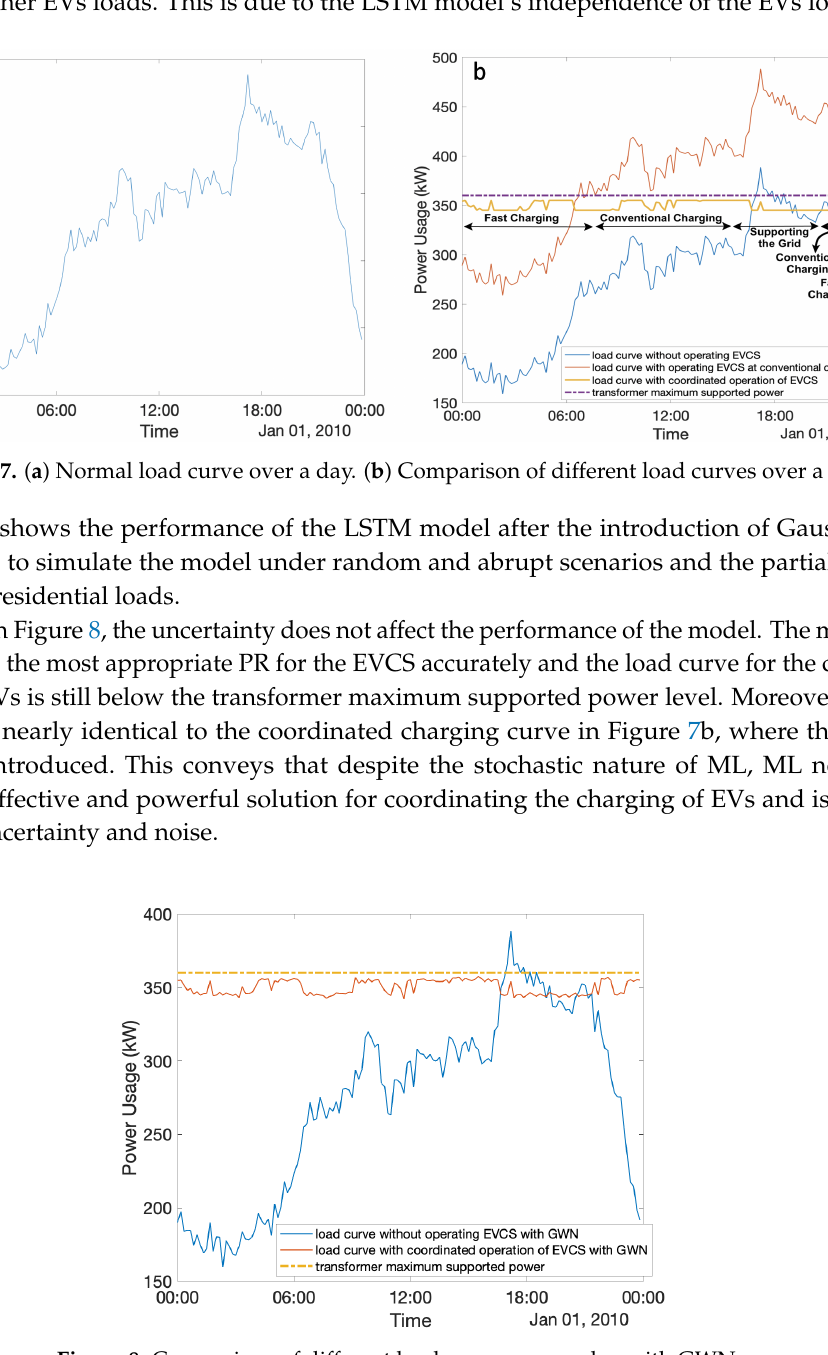
Figure 8. Comparison of different load curves over a day with